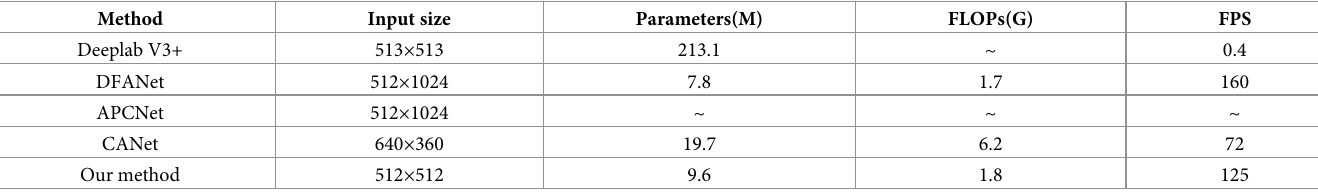
Table 5. Comparison of execution speed of different algorithms on the CUOID dataset.